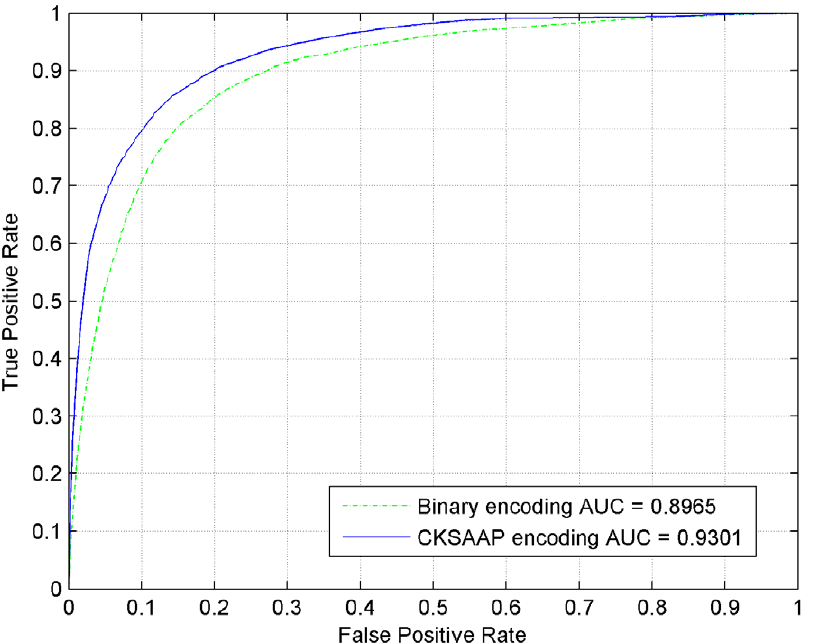
Figure 1. ROC curves of CKSAAP_PhSite and the binary encoding scheme in terms of serine (S) site prediction based on the training dataset.